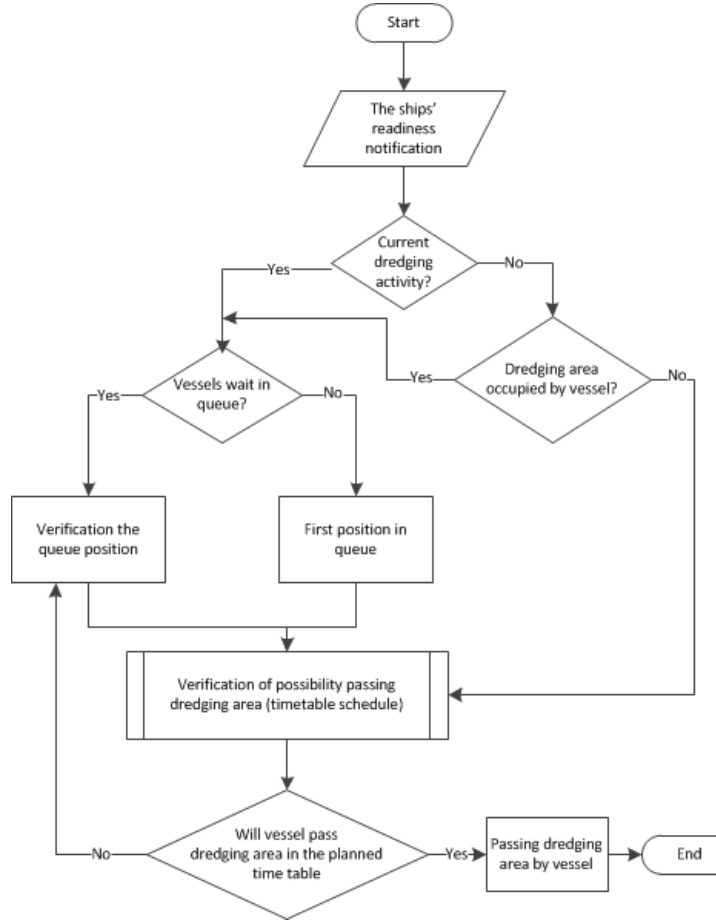
Figure 2. Algorithm of vessel traffic taking place in the area of dredging works.